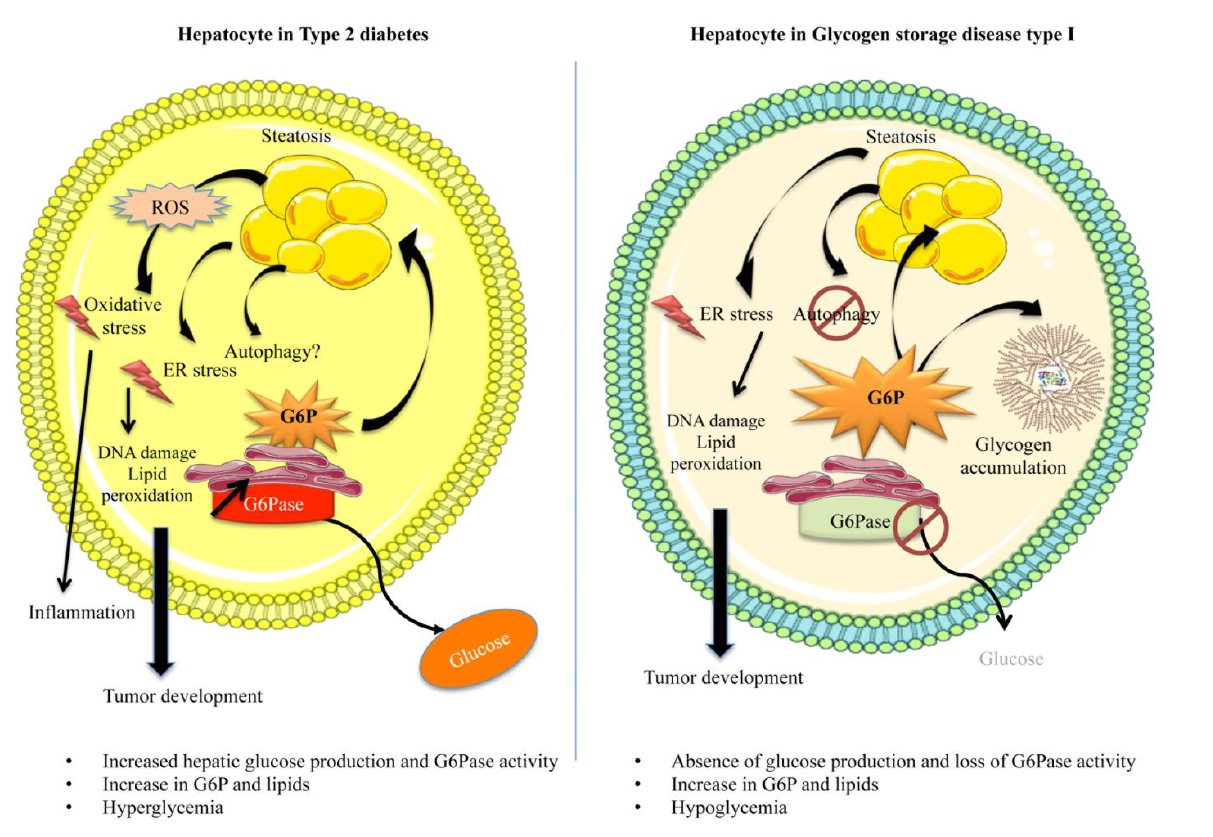
FIGURE 2: Dysfunction of hepatocyte metabolism in type 2 diabetes and GSDI leads to cell stress. Type 2 diabetes is associated with hyperglycemia partially due to an overproduction of glucose by the liver, since G6Pase activity is increased, whereas GSDI is associated with hypoglycemia due to the absence of G6Pase activity. However, these two diseases share similar hepatic metabolism leading to the development of fatty liver. In type 2 diabetes, hyperglycemia leads to an increase of the metabolic flux downstream of G6P, whereas in GSDI, the absence of G6Pase activity is responsible for G6P accumulation. In both diseases, this results in an activation of de novo lipo- genesis. In addition, GSDI is characterized by glycogen accumulation. These metabolic perturbations are responsible for cell stress such as ER stress. Even though mitochondrial dysfunctions were shown in both diseases, increased ROS production and oxidative stress has only been observed in diabetes, but not in GSDI. In GSDI, autophagy is also clearly decreased, but this is still controversial in diabetes. In both diabetes and GSDI, cell stress could cause DNA and protein damages, lipid peroxidation and finally, the development of hepatic